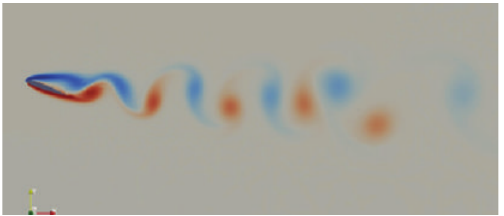
Figure 2: Karman vortex street for Re = 400 and t = 13.